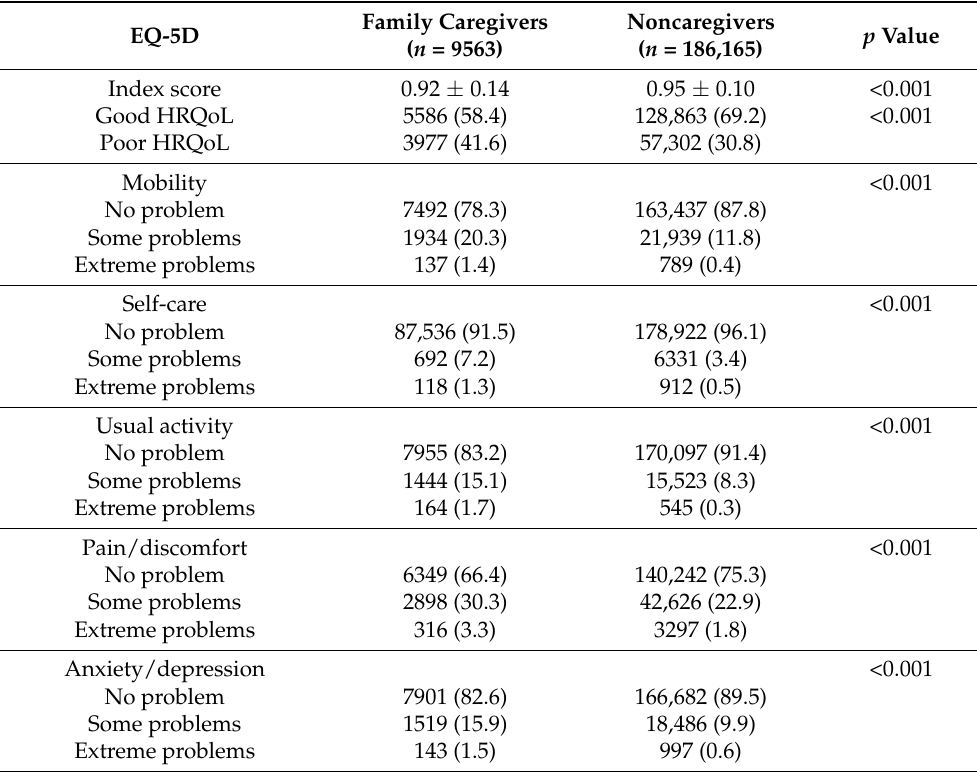
Table 2. Comparisons of the EQ-5D index score and five dimensions between family caregivers of people with dementia and